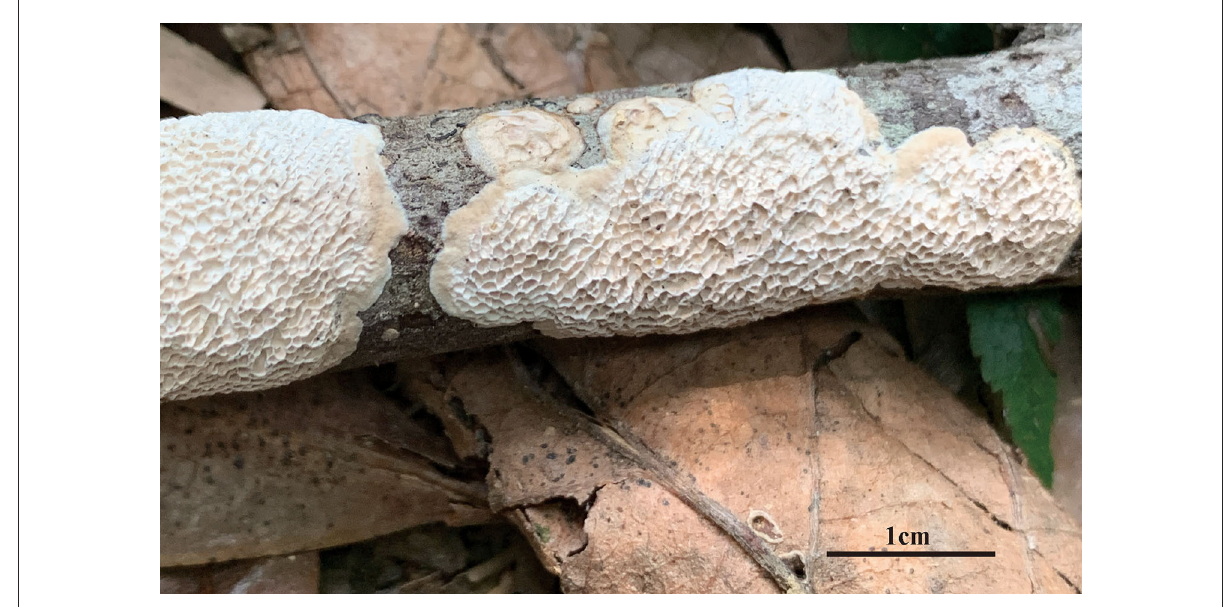
FIGURE11 Basidiocarps of Megasporia sinuosa (holotype, Dai 22210).